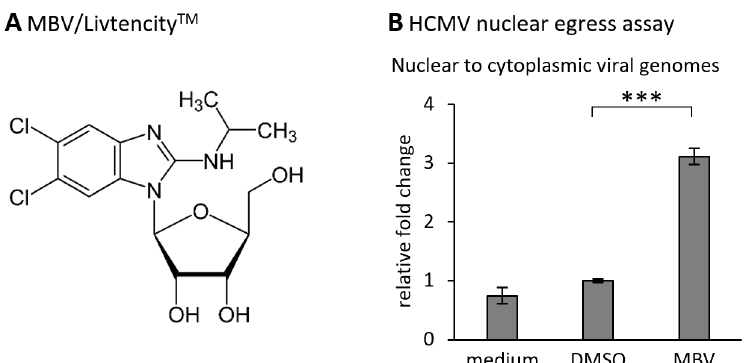
Figure 9. Maribavir (MBV) represents a newly approved anti-HCMV drug with nuclear egress- blocking activity. ( A ) Chemical structure of the benzimidazole riboside MBV. ( B ) The mode of antiviral activity of MBV was determined by a quantitation of viral encapsidated genomes [128]. The virus-specific qPCR-based measurements were performed after cellular fragmentation, i.e., using nuclear versus cytoplasmic fractions, using the recently established nuclear egress assay [125]. The significance between DMSO and MBV was calculated by Student’s t -test (*** p < 0.001).